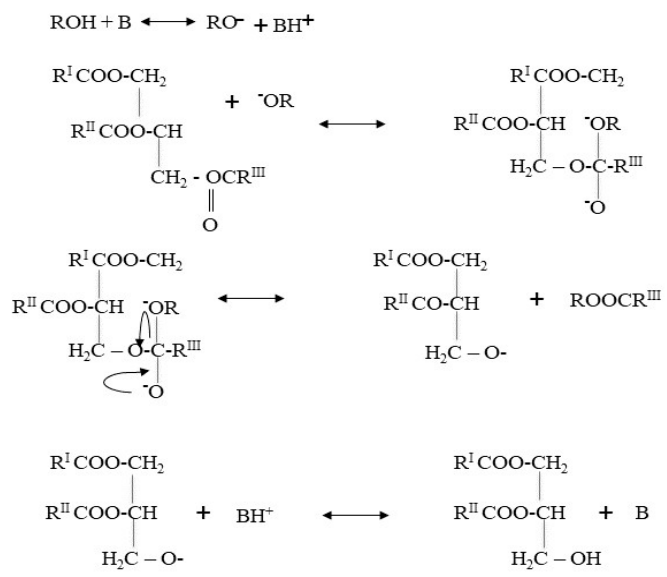
Figure 6. Mechanism of base-catalyzed transesterification.